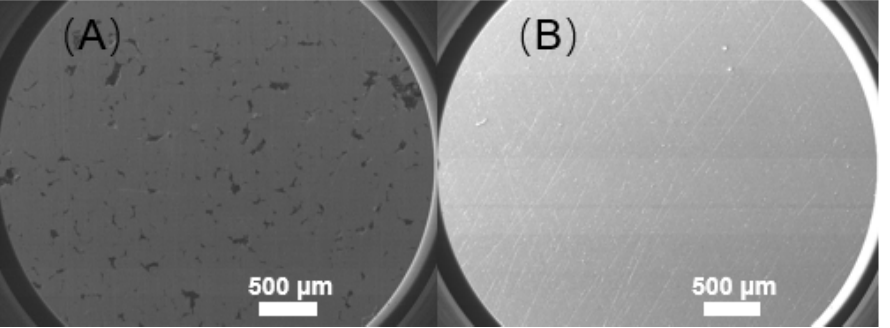
Figure 1. A typical SEM micrograph of the polished surface of ( A ) copper/MgP-graphite composites and ( B ) copper.